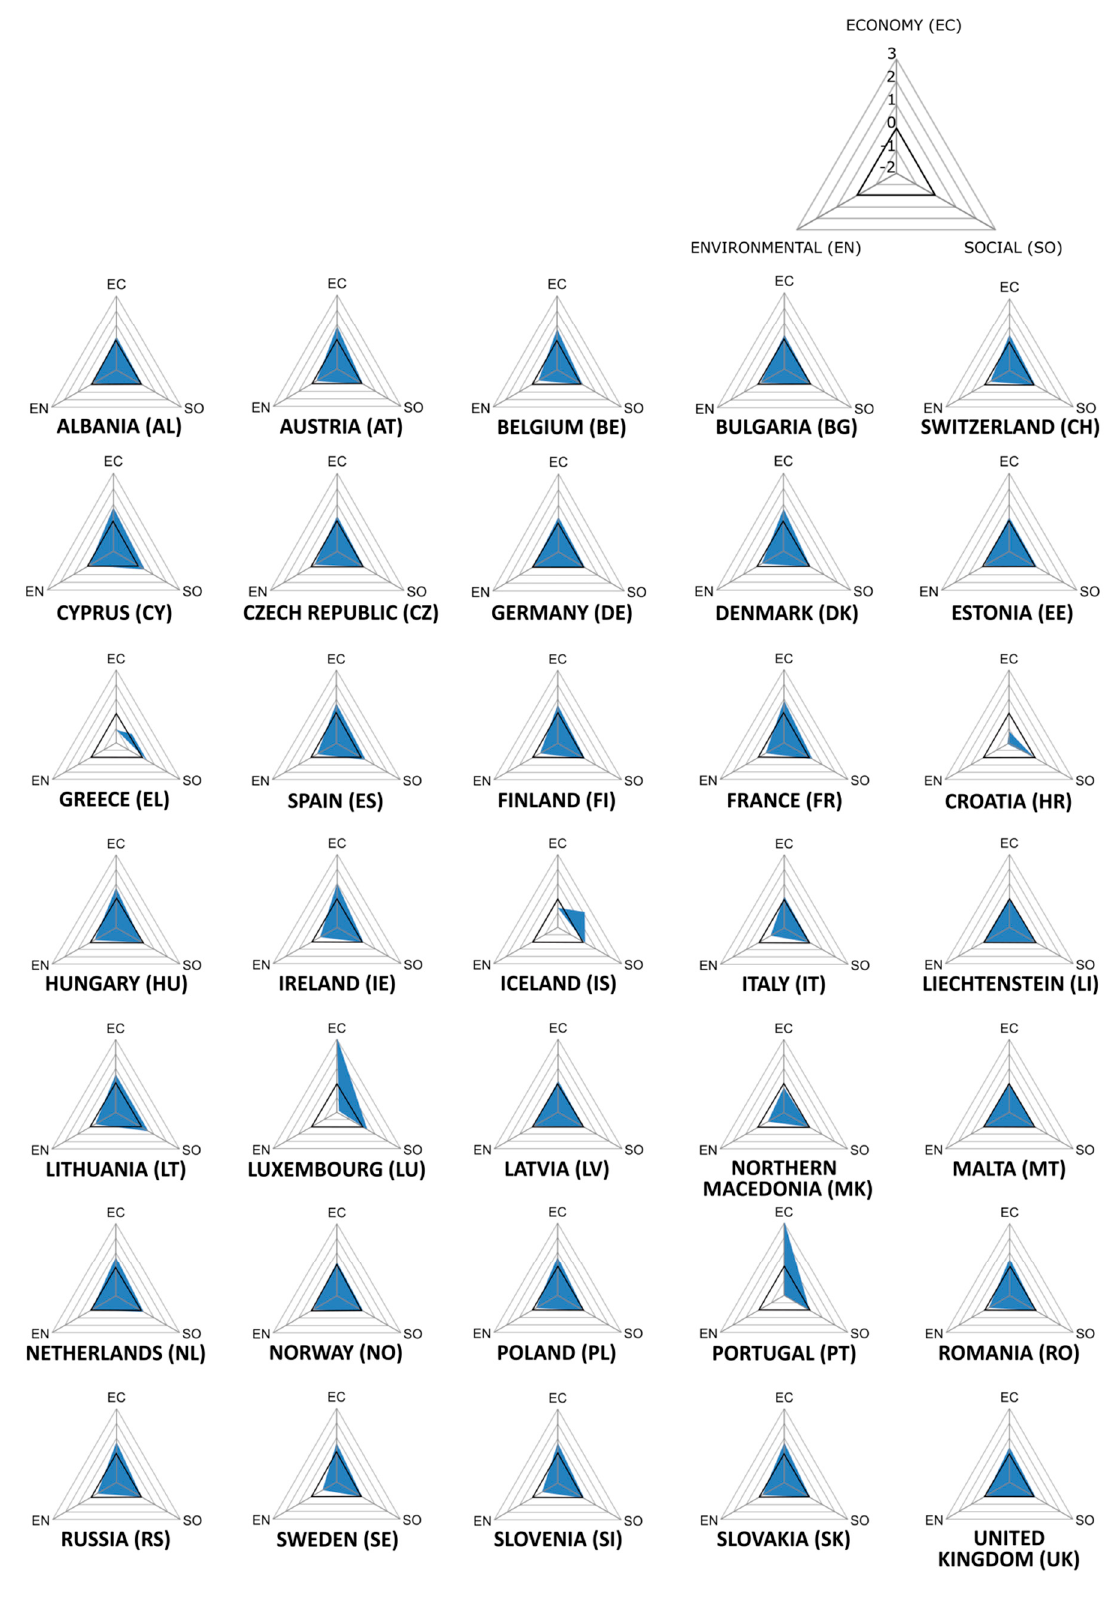
Figure A5. Sustainability assessment of local change directions in country - DEGURBA level 1